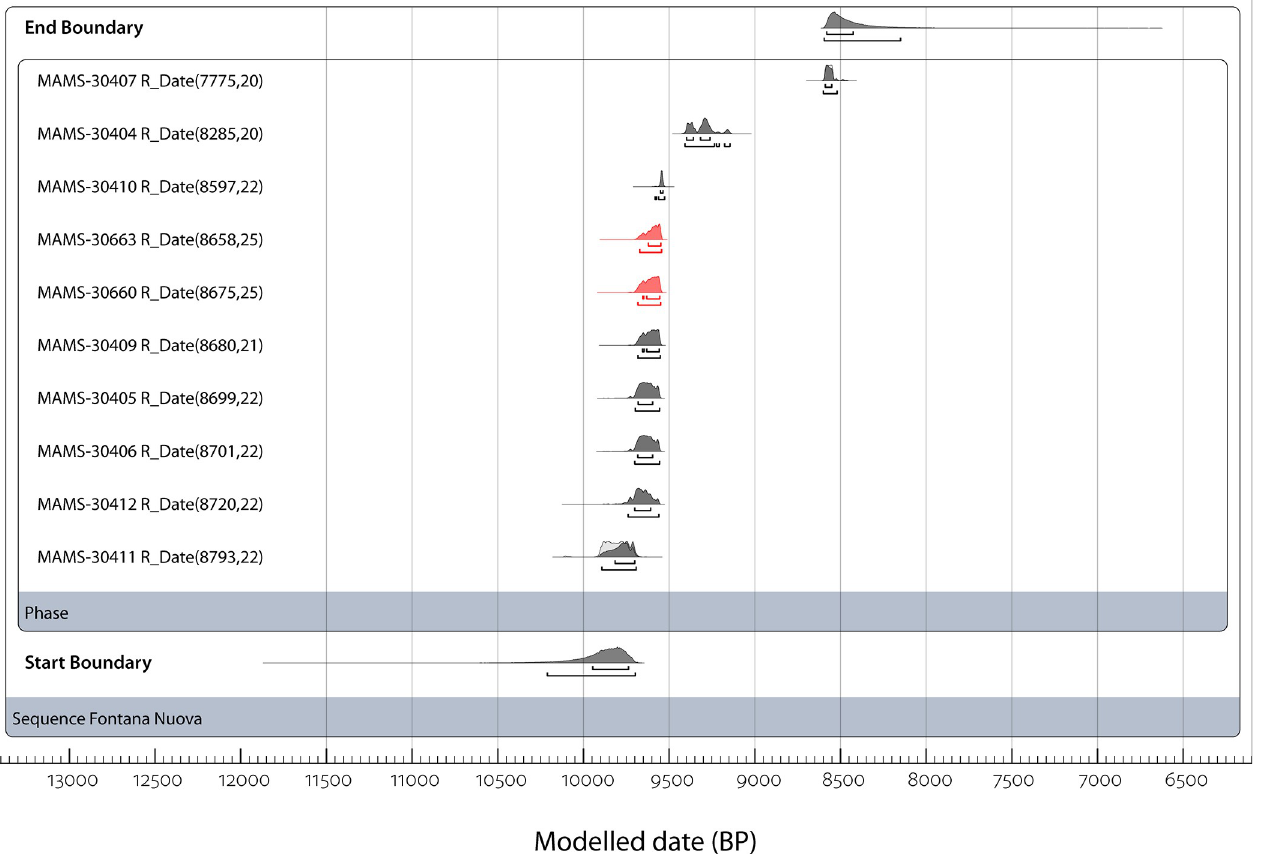
Fig 2. Radiocarbon dates. Plot of the modelled calibrated ages of the ten collagen extracts from human and other faunal skeletal remains recovered at Fontana Nuova. The two human teeth have probability distributions marked in red (MAMS-30660 and MAMS-30663).